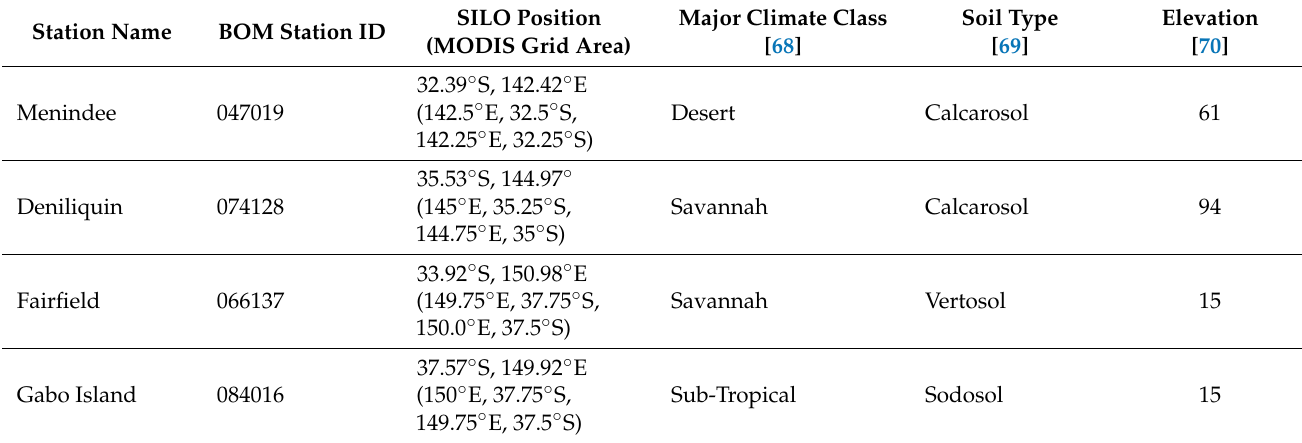
Table 1. Geographic locations and physical characteristics of selected sites in the Murray Darling